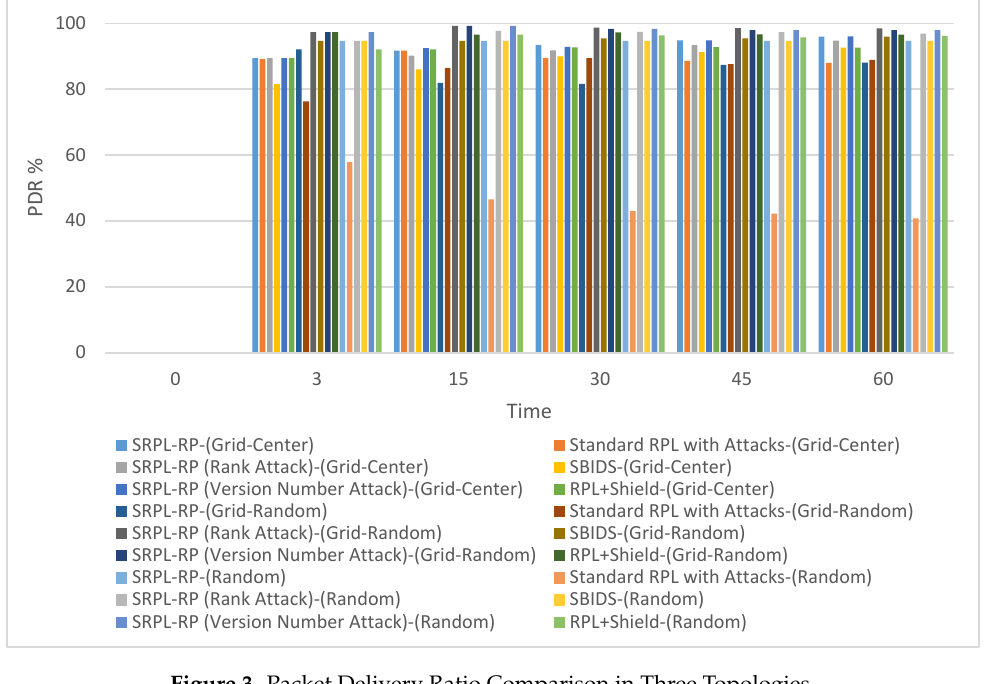
Figure 3. Packet Delivery Ratio Comparison in Three Topologies. Table 3. Packet Delivery Ratio Comparison in Grid-Center Topology.